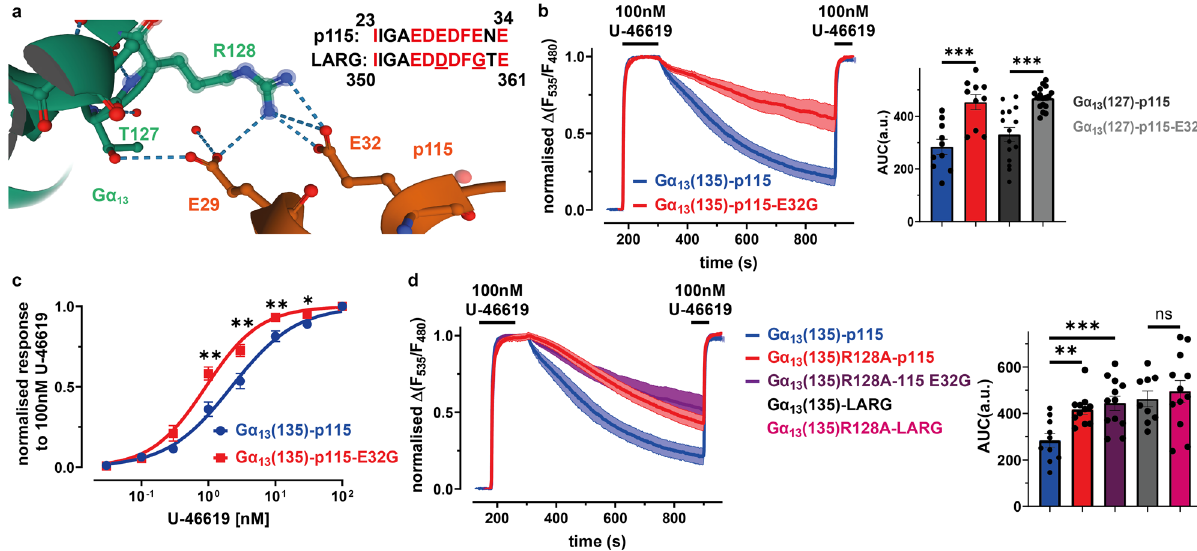
Fig. 5 Identi fi cation of molecular interactions between the alpha-helical domain of G α 13 and p115 required for fast dissociation kinetics. a A crystal structure of the G α 13/i -p115-RhoGEF interaction revealed an interaction site located N-terminal of the RH domain of p115 involving E29 and E32 of p115, as well as T127 and R128 of G α 13 (Chen, Z., Sprang, S.R. (2005) Crystal Structure of the p115RhoGEF rgRGS Domain in A Complex with Galpha(13):Galpha(i1) Chimera, doi: 10.2210/pdb1shz/pdb) 46,47 . The comparison of this p115 motif with its LARG counterpart exposed a difference of only two amino acids (underlined: E29 and E32 in p115; amino acids in red directly interact with G α 13 ). b A single glutamic acid to glycine mutation in the N-terminal binding motif of p115 [red, n = 10, mean AUC = 452.6] displayed highly signi fi cant slowed off-kinetics compared to wt-p115 [blue, n = 10, mean AUC = 283.6, unpaired t -test, *** P = 0.0006] in the agonist induced interaction (as described in Fig. 2c) with a G α fl uorophore was inserted after amino acids 135. The 13 where the same was true when a G α 13 with the fl uorophore inserted after amino acids 127 was used. [p115: dark grey, n = 15, mean AUC = 331.1; p115-E32G: light grey, n = 17, mean AUC = 467.6, unpaired t-test with Welch´s correction; ** * P = 0.0001] c Comparison of concentration-response curves for the G α 13 - p115 [blue] and G α 13 -p115-E32G [red; for 0.03 nM, 0.3 nM, 3 nM, 30 nM: n = 9; for 0.1 nM, 1 nM, 10 nM: n = 10] interactions. With an EC 50 value of 0.92 nM the G α 13 -p115-E32G curve is left-shifted compared to the G α 13 -p115 curve with an EC 50 value of 2.22 nM. Signi fi cant differences in sensitivity were found for an agonist range of 1 nM to 30 nM [unpaired t -test with or without Welch´s correction, dependent on outcome of F-test to compare variances, 1 nM: ** P = 0.0019, 3 nM: ** P = 0.0059, 10 nM: ** P = 0.0057, 30 nM: * P = 0.0232]. d Mutation of arginine to alanine in position 128, the amino acid that directly interacts with E32 of p115, of G α 13 [ = G α 13(135)R128A, red, n = 11, mean AUC = 416.9] showed a signi fi cantly longer interaction time with p115 compared to wt-G α 13 [blue, data from Fig. 5b; ** P = 0.0058], like the p115-E32G mutation. The same was true when both, the p115 and the G α 13 mutant was used [purple, n = 12, mean AUC = 443.8; ordinary one-way ANOVA with Tukey´s multiple comparison test; *** P = 0.0008]. The G α 13 (135)R128A- LARG interaction [pink, n = 12, mean AUC = 495] however revealed no signi fi cant difference compared to the wt-G α 13 -LARG interaction [grey, n = 9, mean AUC = 462.2; unpaired t -test, ns P =